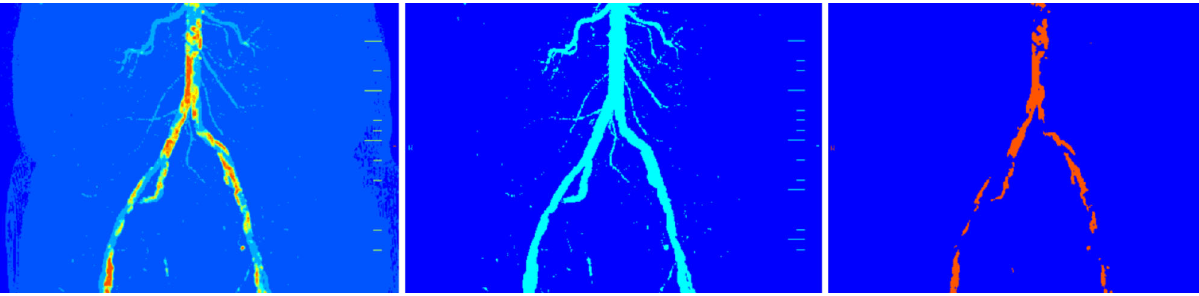
Fig. 4 Overall segmentation model of vascular system for calcification differentiation (left), model of overall vascular system (middle) and calcifi- cation model